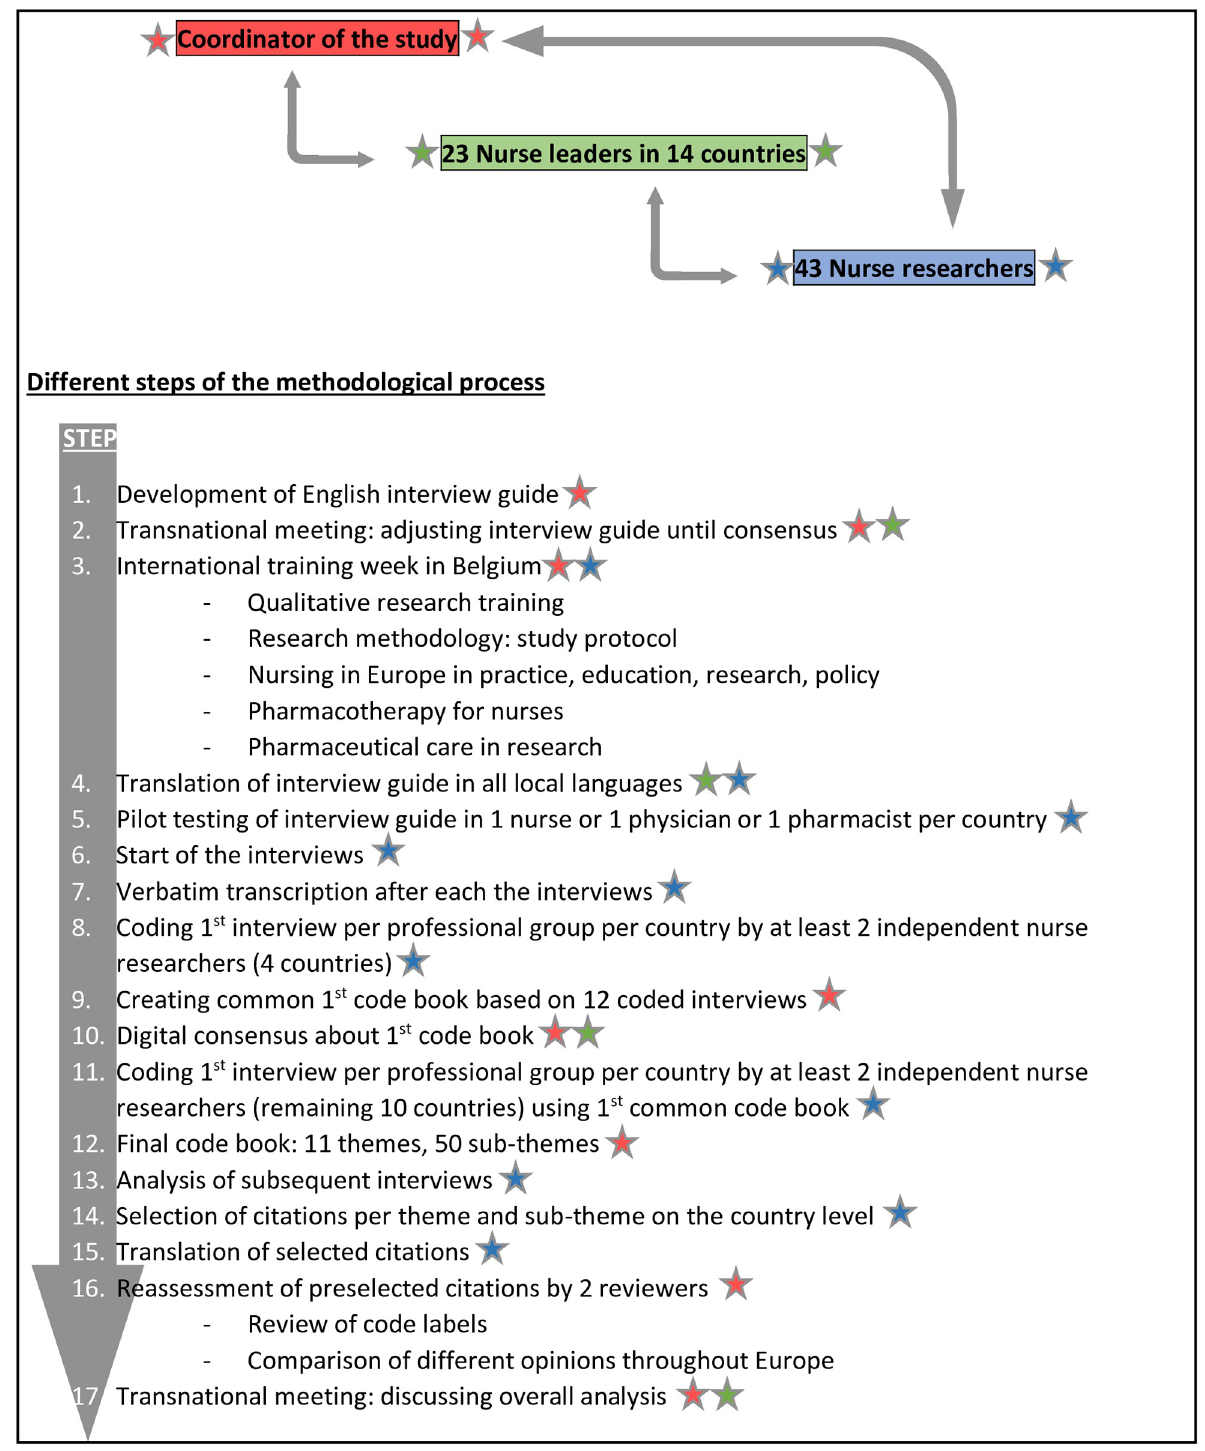
Fig 1. International approach to increase methodological quality.